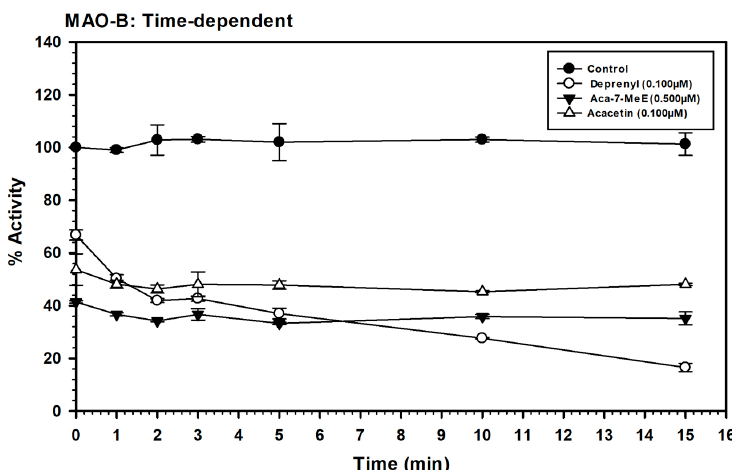
Figure 5. Time-dependent inhibition of recombinant human MAO-B by deprenyl (0.100 μ M), acacetin 7-methyl ether (Aca-7-MeE) (0.500 μ M), and acacetin (0.100 μ M). Each point represents mean ± S.D. of triplicate values.